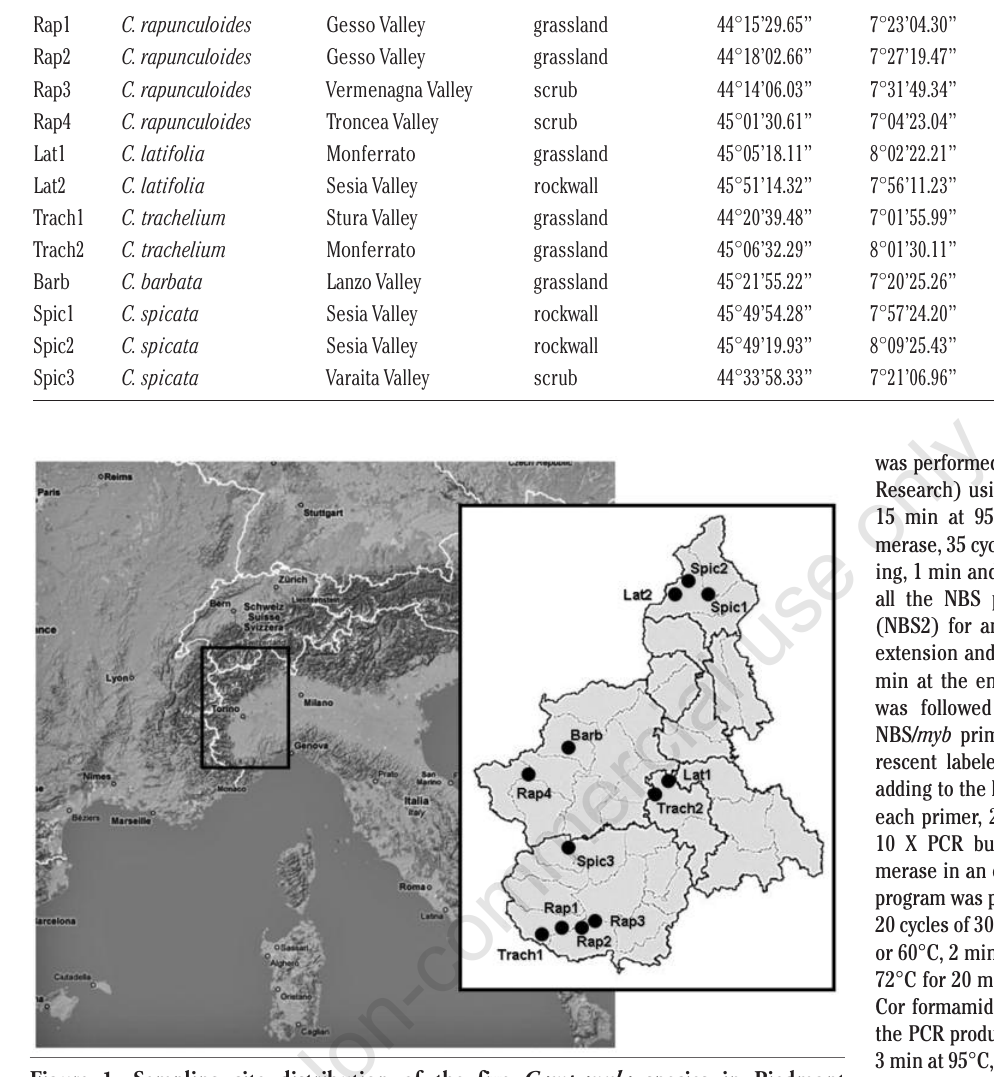
Table 1. Sampled Campanula species and populations with their identification code (ID), geographical location, soil, latitude (La.), longitude (Lo.), altitude (Al.) and sample size (n). ID